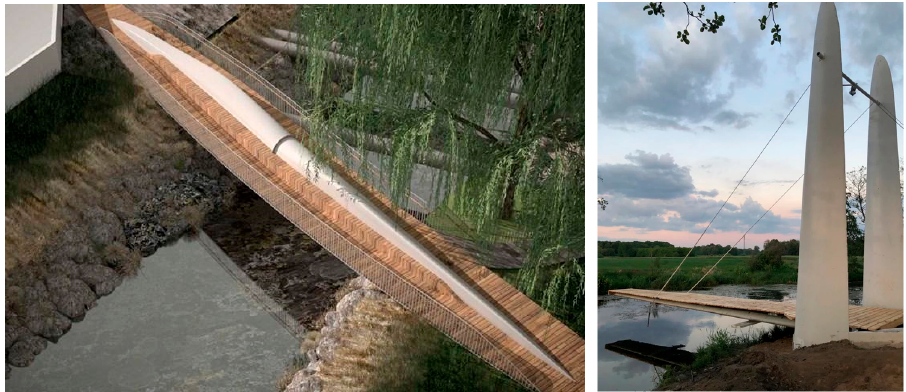
Figure A9. Blade-made load-bearing structural supports for pedestrian bridges [49].